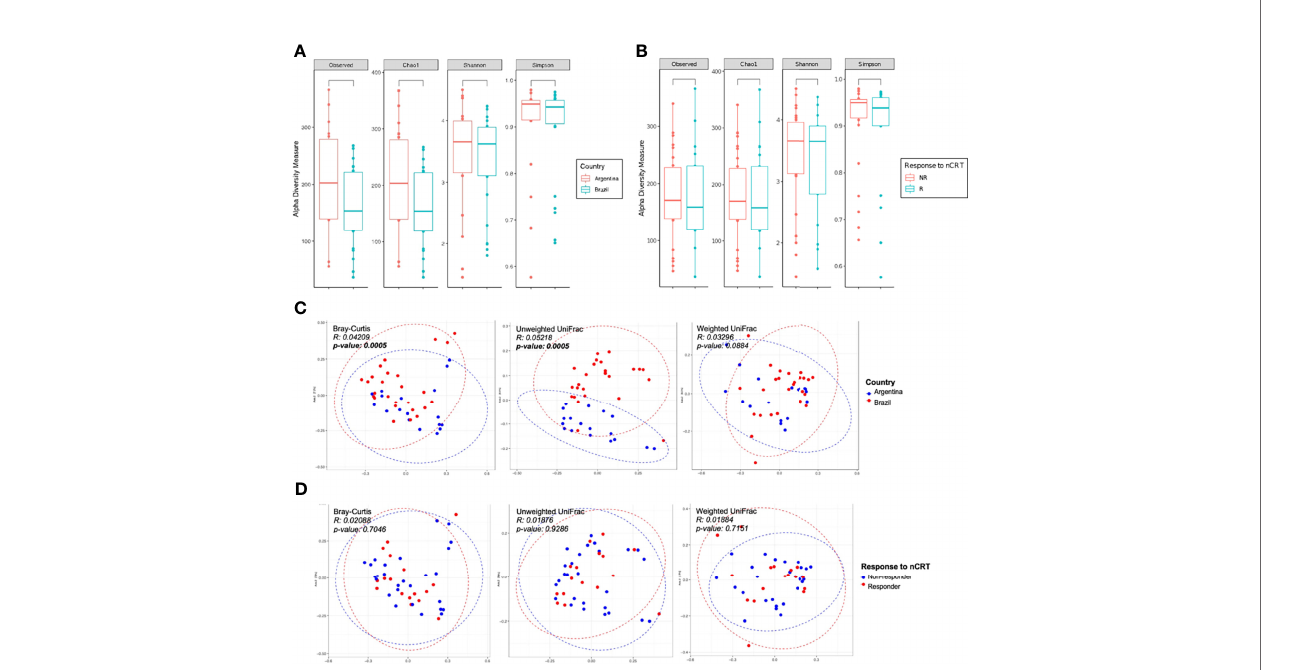
FIGURE 3 | Alpha and beta diversity of LARC biopsies before neoadjuvant treatment. Boxplots showing the bacterial alpha diversity using different metrics (observed ASVs, Chao1, Shannon, and Simpson indices) between (A) country of origin of the samples: Argentina and Brazil; (B) response to neoadjuvant treatment: R and NR patients. No statistically signi fi cant differences were observed (Mann – Whitney U test, p- value > 0.05); PCoA ordination plots showing the bacterial beta diversity using three distance metrics (Bray – Curtis, unweighted and weighted UniFrac) comparing (C) country of origin of the samples: Argentina and Brazil; and (D) response to neoadjuvant treatment: R and NR patients. Samples from Argentina and Brazil formed two separate clusters (Bray – Curtis and unweighted UniFrac distances, PERMANOVA/ADONIS p- value <